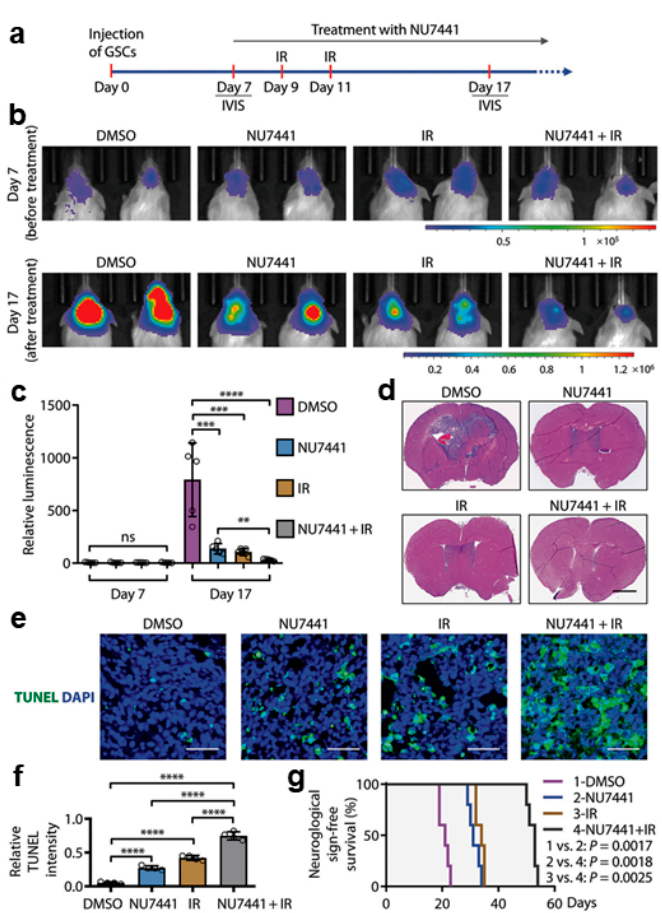
Figure 1. Inhibiting DNA-PKcs in combination with IR improved GB treatment. ( a – c ) In vivo bioluminescent imaging of orthotopic GB xenografts derived from H2S GICs expressing luciferase in immunocompromised NSG mice. Seven days after GIC transplantation, NSG mice were treated with DNA-PKcs inhibitor (NU7441) or DMSO (control) by intraperitoneal injection and/or irradiated (IR; 2 × 2 Gy) on day 9 after GIC transplantation. Representative images ( b ) of the four indicated treatment groups on day 7 (before treatment) and day 17 (after treatment) and quantifications ( c ) of tumor growth in mouse brains are shown. Data are means ± SD. n = 5 mice per group. ANOVA analysis was used to assess the significance. **, p < 0.01, ***, p < 0.001, and ****, p < 0.0001. ( d ) Representative images showing H&E staining of cross-sections of mouse brains bearing GIC- derived tumors from four groups of mice treated with NU7441, IR (irradiation), NU7441 + IR, or DMSO (control). Scale bar, 2 mm. ( e , f ) TUNEL assay detecting apoptosis (green) in the GB xenografts treated with the DNA-PKcs inhibitor NU7441, irradiation (IR), NU7441 + IR, or DMSO (control) and counterstained with DAPI (blue) to indicate nuclei ( e ). Quantifications of cell apoptosis from four treatment groups ( f ). Scale bars, 50 µ m. ANOVA analysis was used to assess the significance. Data are means ± SD. n = 4 independent experiments (about 200 cells per arm). ****, p < 0.0001. ( g ) Kaplan–Meier survival curves of mice intracranially transplanted with H2S GSCs and treated with the DNA-PKcs inhibitor NU7441, irradiation (IR), NU7441 + IR, or DMSO (control). n = 5 animals per group. Log-rank analysis was used. Control versus NU7441, p = 0.0017; control versus IR, p = 0.0017; control versus NU7441 + IR, p = 0.0017; NU7441 versus NU7441 + IR, p = 0.0018; and IR versus NU7441 + IR, p = 0.0025 (modified after [67] with